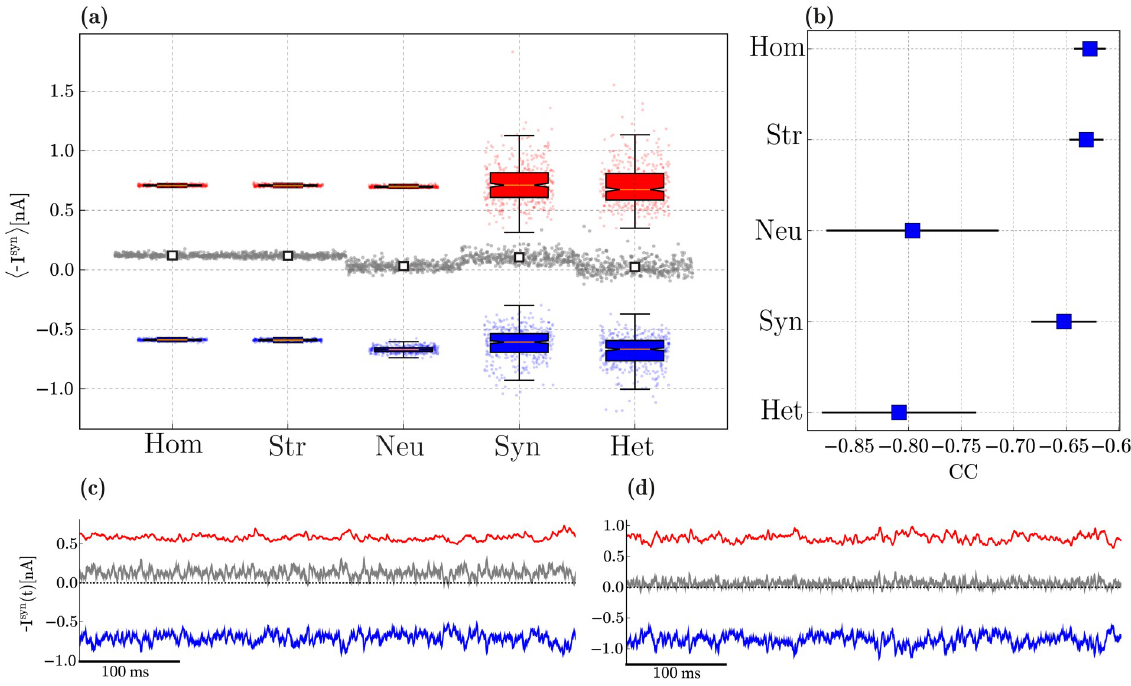
Fig 5. Balance of excitation and inhibition in excitatory neurons driven by background, Poissonian input at ν Distribution of mean amplitudes of excitatory (blue) and inhibitory (red) membrane currents onto E neurons in the different conditions, as well as the absolute difference between them (grey). For each condition, we show the single data points, where the currents onto a given neuron are summarized as a set of 3 points ( h I exc i in blue, h I inh i in red and | h I inh i − h I exc i | in grey). Overlaid on top of these data points are the distributions across all the neurons, summarized as box-plots: the box represents the first and third quartiles (IQR); the median is marked in red; the whiskers are placed at 1.5 IQR and the outliers can be seen in the underlying data points. The white markers in the middle display the mean difference of synaptic amplitudes across all neurons, for each condition. ( b ): zero-lag correlation coefficient between excitatory and inhibitory synaptic currents (mean and standard deviation across the E population). ( c, d ): Examples of the total excitatory and inhibitory synaptic currents received by a randomly chosen E neuron in the homogeneous and fully heterogeneous conditions, respectively. Results in ( a ) and ( b ) were gathered from 10 simulations per condition.